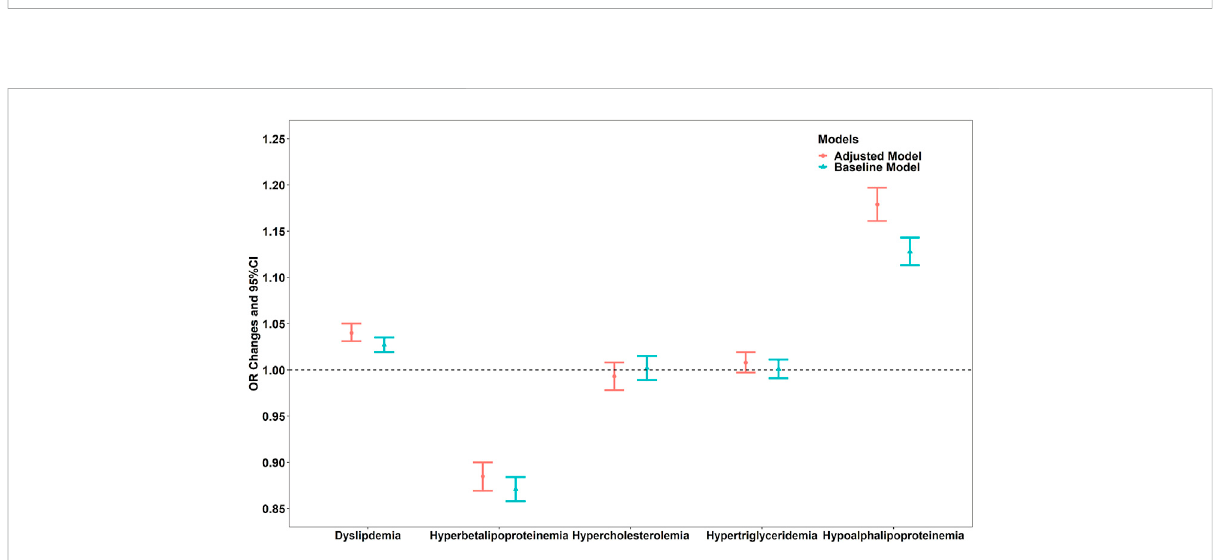
FIGURE 3 Association between a 1- μ g/m 3 increment of PM 2.5 and